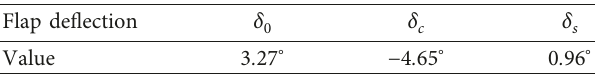
Table 2: The trimming results of the flap